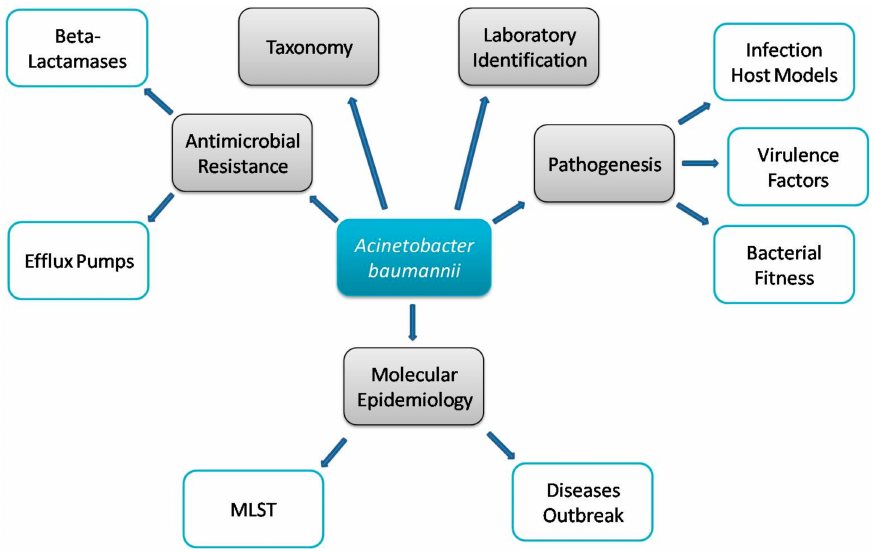
Figure 1. Pathobiology of A. baumannii